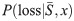
Percentage of disease variants with prediction scores at the 1% false positive rate threshold in putatively neutral variants.For each function f, the bars indicate the percentage (%) of disease mutations that have a greater P(loss|S¯,x) and P(gain|S¯,x) than a conservative threshold at 1% false positive rates (FPR). These thresholds are estimated from the null distributions of P(loss|S¯,x) and P(gain|S¯,x) on the set of dbSNP neutral data, respectively. *Indicates significant p-value measured as a one-tailed Fisher’s Exact test after Bonferroni correction for multiple hypothesis testing (p < 8.62 ⋅ 10−4). The red line indicates the percentage of neutral variants that have greater P(loss|S¯,x) and P(gain|S¯,x) which is exactly 1%.